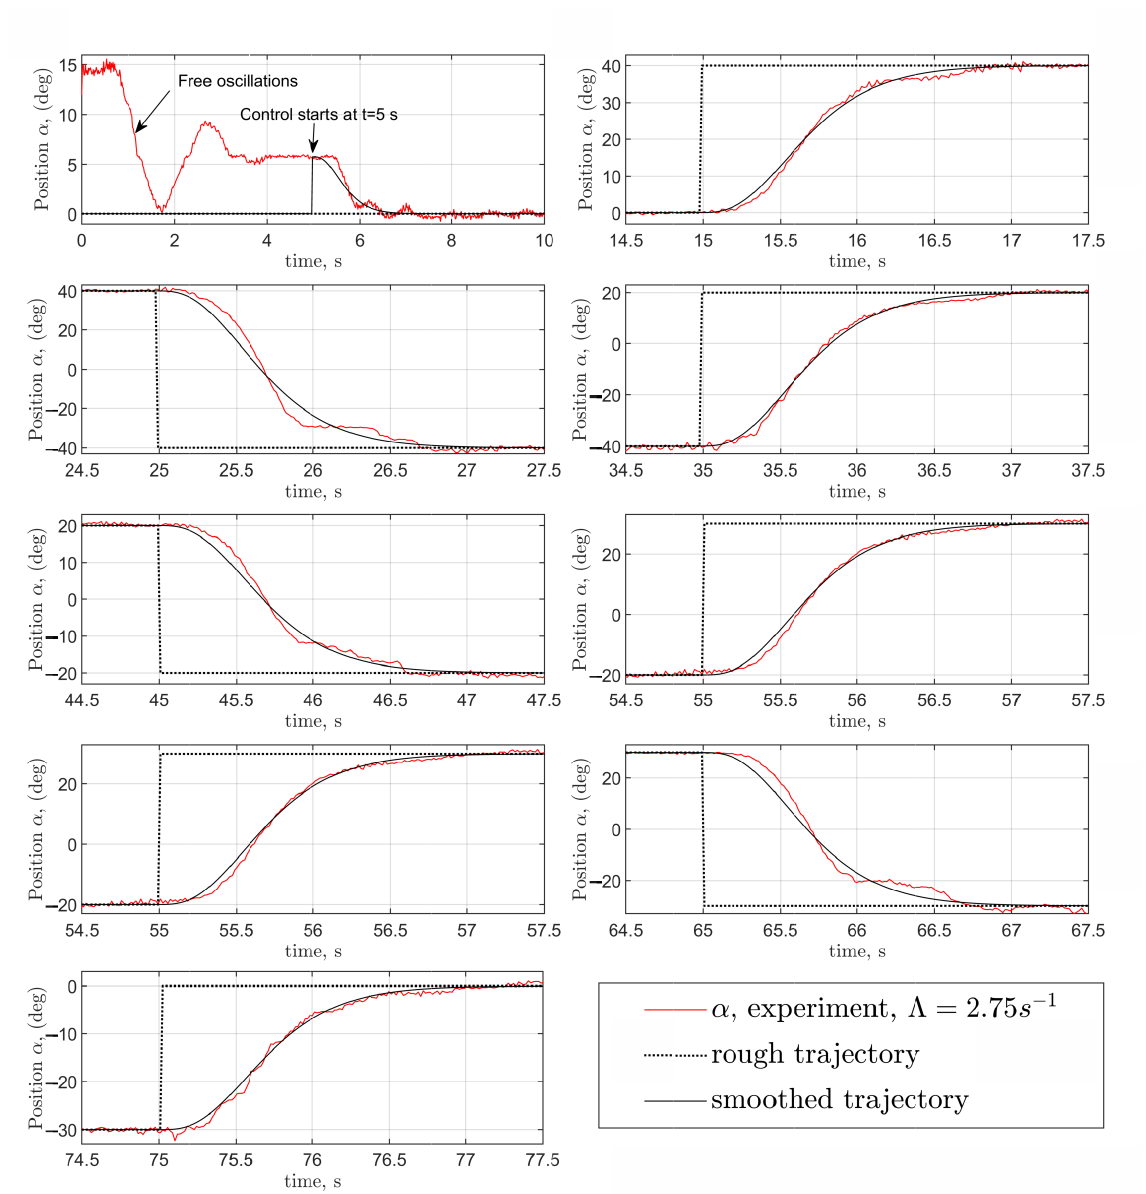
Figure 10. Detailed view of trajectory tracking from an experiment with Λ = 2.75 s − 1 . To show that the effect of external torque perturbations is also neutralized in real life, “qualitative” measurement series were elaborated, where the external disturbance was induced manually by pushing one of the arms belonging to the test stand arm (the measured results are shown in Figure 13, a similar magnitude of torque to the simulated disturbance could have been achieved by suspending weights to the arm, but the coordination of the weights’ loading and unloading with the simulation load timing would have been too complicated). Each manual push lasted about 1 to 3 s. It is worth mentioning here that, in this experiment, the nominal trajectory was not predefined, but was generated in real-time by the microcontroller based on rough trajectory data provided by an incremental encoder knob. Each time, the experimenter turned the encoder knob by one position, the rough trajectory increased or decreased by 2 degrees, and this was fed to the smoothed trajectory generator